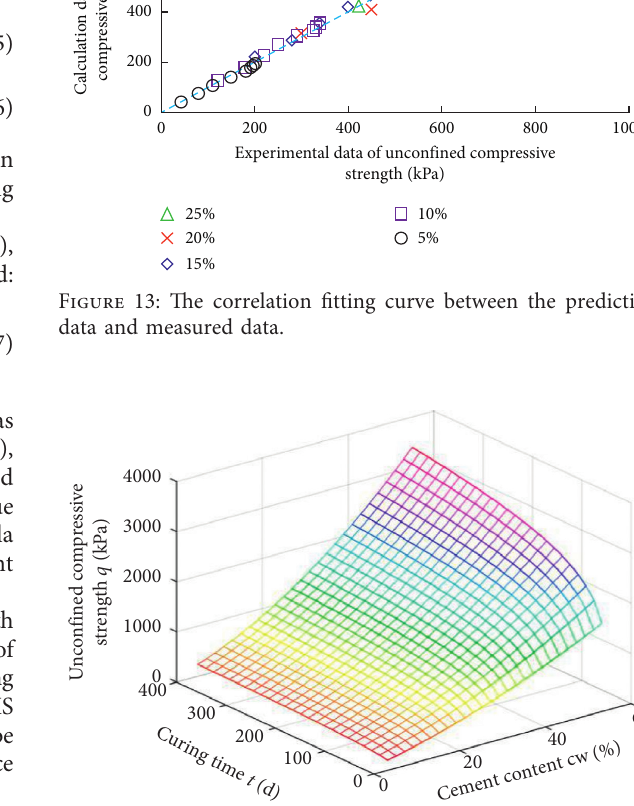
Figure 14: The prediction model of the UCS of the